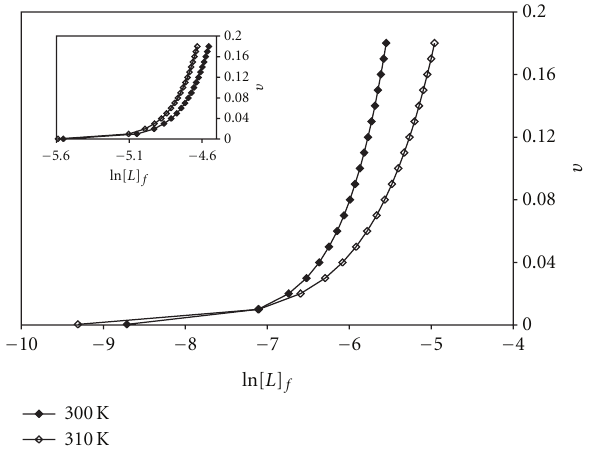
Figure 7: Binding isotherm plots for [Pt(bpy)(Oct-dtc)]NO 3 and the inset for [Pd(bpy)(Oct-dtc)]NO 3 in the interaction with CT- DNA.